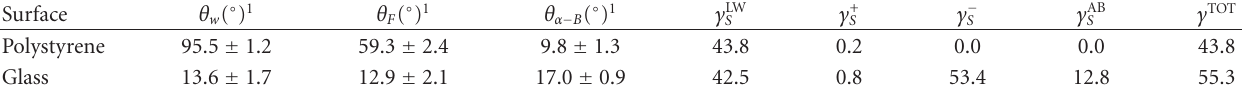
Table 1: Contact angles ( ◦ ) and surface energies (mJ · m − 2 ) of solid